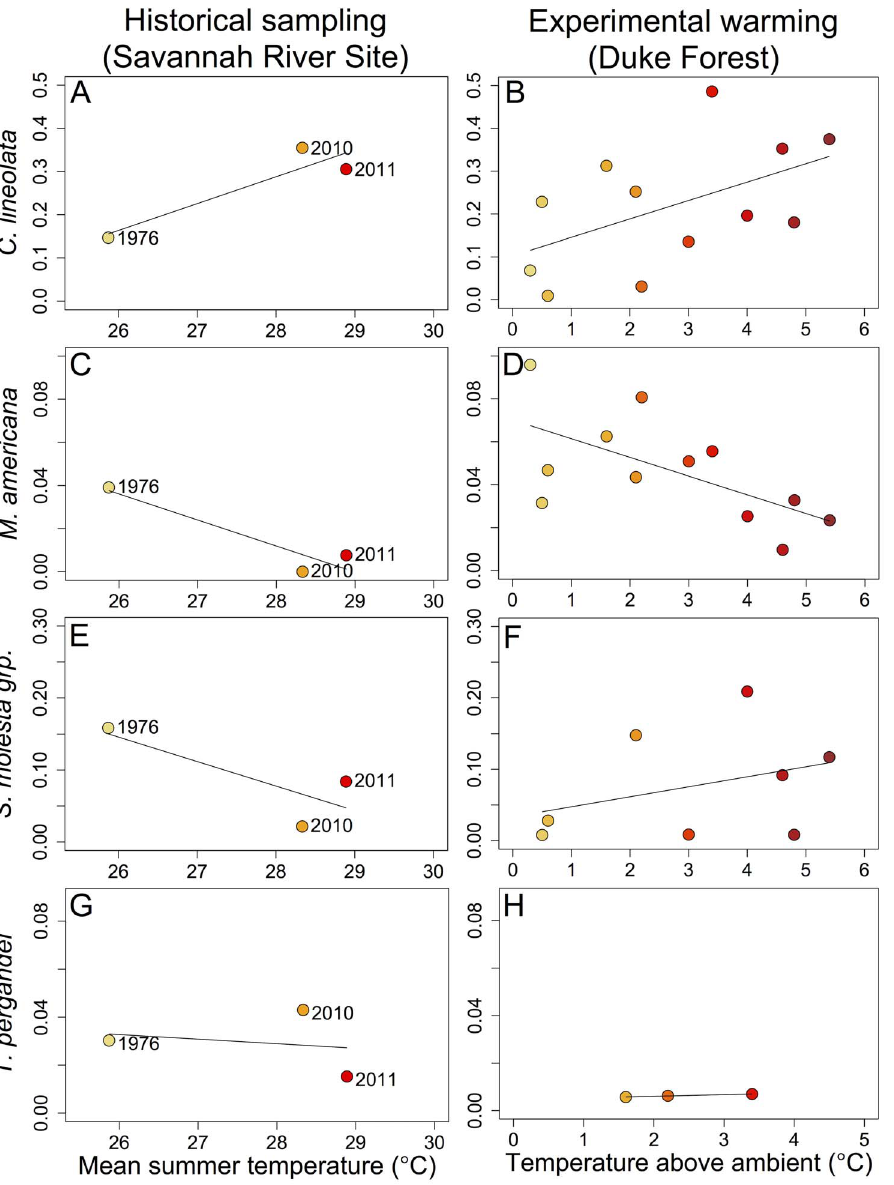
Figure 3. Relationships between temperature and species relative activity-densities for ant species that occurred at both Savannah River Site and Duke Forest. Species are: A–B) Crematogaster lineolata , C–D) Myrmecina americana , E–F) Solenopsis molesta group, G–H) Temnothorax pergandei . Dots for Savannah River Site represent sampling periods and dots for Duke Forest represent warming chambers where the species occurred. Warmer colors indicate warmer